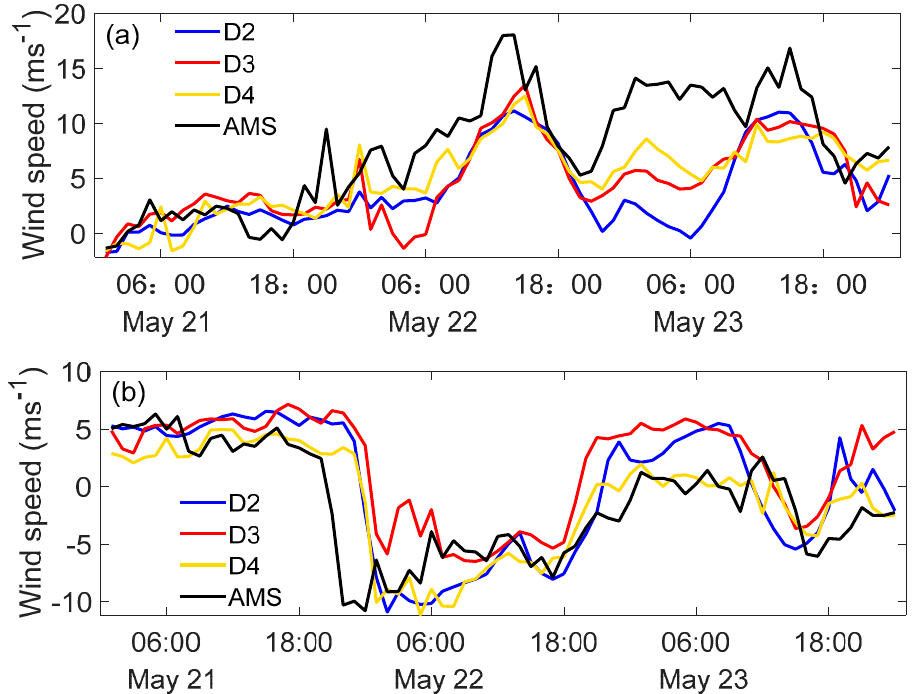
Figure 7. Time series of simulated wind speeds for domains D2, D3, and D4: ( a ) u component (m/s); ( b ) v component (m/s).